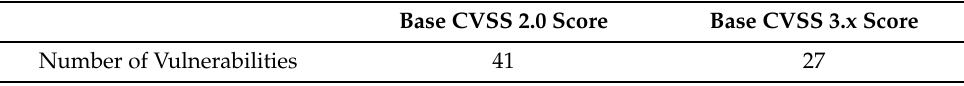
Figure 4. Vulnerability severity histogram divided into the base CVSS 2.0 and 3.x scores for environ- ment A. Table 2. Comparison of the number of vulnerabilities detected according to the selected standard for environment